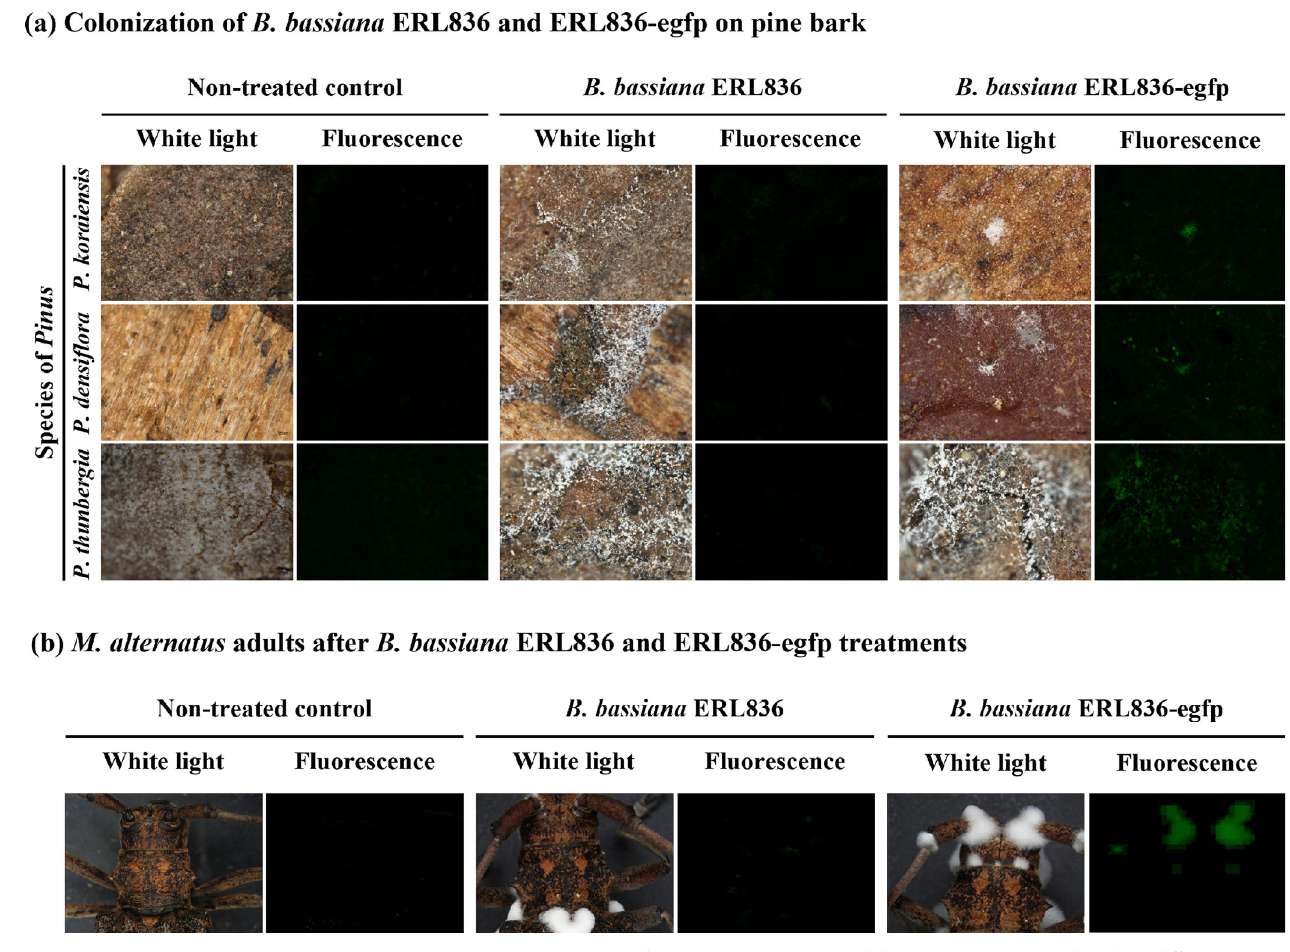
Fig 4. Colonization of B . bassiana ERL836 on pine tree barks. ERL836 or egfp–expressing ERL836 conidial suspension was sprayed on three different species of pine tree barks and the egfp signal was detected under a fluorescence microscope (a). The fungus–infected M . alternatus adults were observed under the same conditions at 12 days after treatment